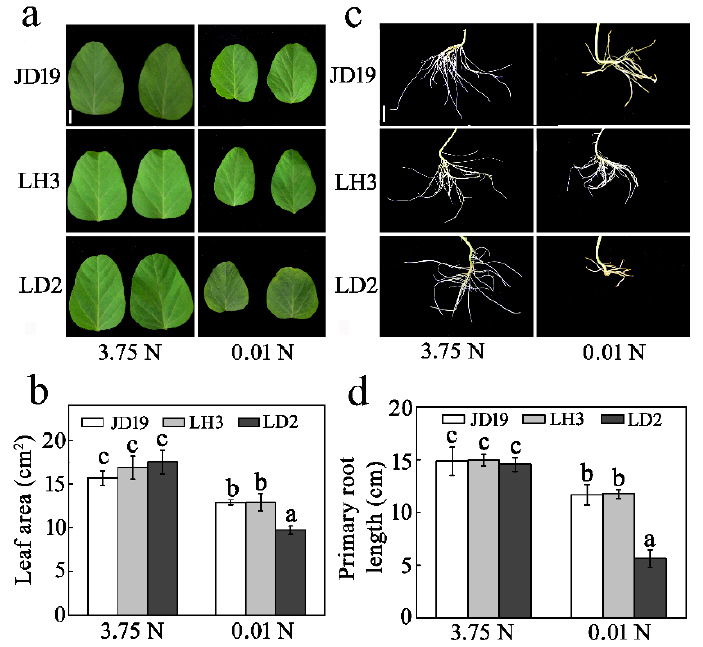
Figure 1. The phenotype of three soybean cultivars under low-N stress. ( a ) leaf phenotype, ( b ) leaf area, ( c ) root phenotype, ( d ) primary root length. Bar: 1 cm. Data are means ± SE ( n = 3, p < 0.05). The letters show significant differences under N conditions.